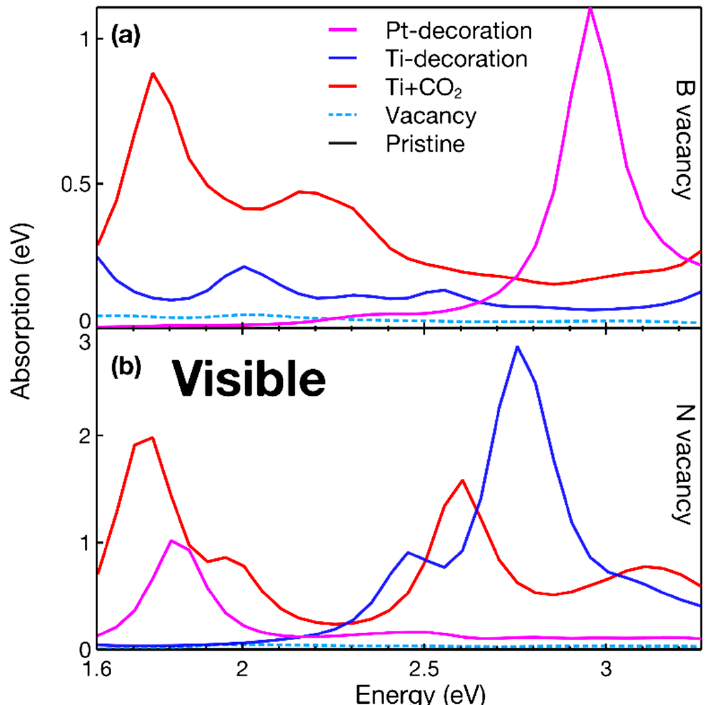
Figure 4. Absorption in the visible region for the cases considered. In ( a ) we see the cases with the B atom removed from the hBN surface, while in ( b ) we see those with the N atom removed. The Ti decoration in place of an N vacancy in the hBN surface significantly increases the optical absorption in this range. The Pt decoration has a similar, though less noticeable,